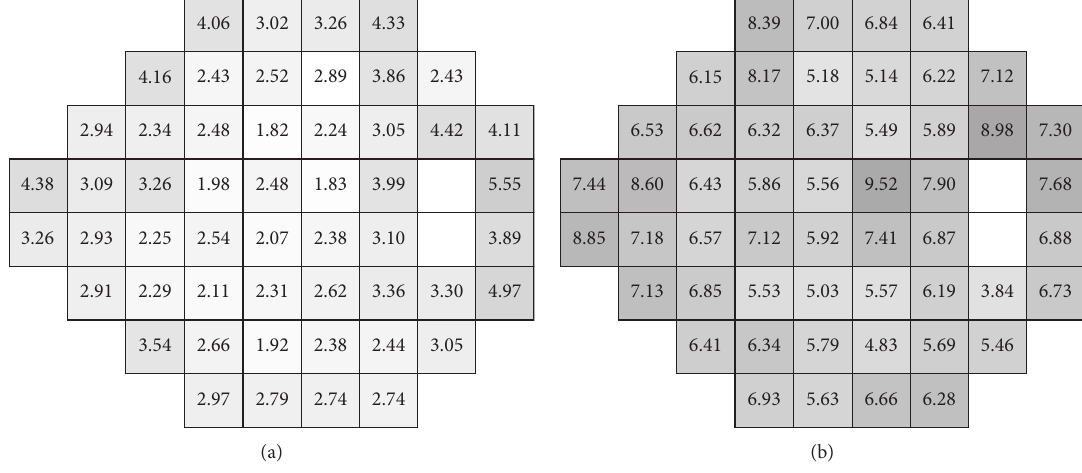
Figure 5: The mean RMS deviation at every test location in the healthy group (a) and the glaucoma group (b).